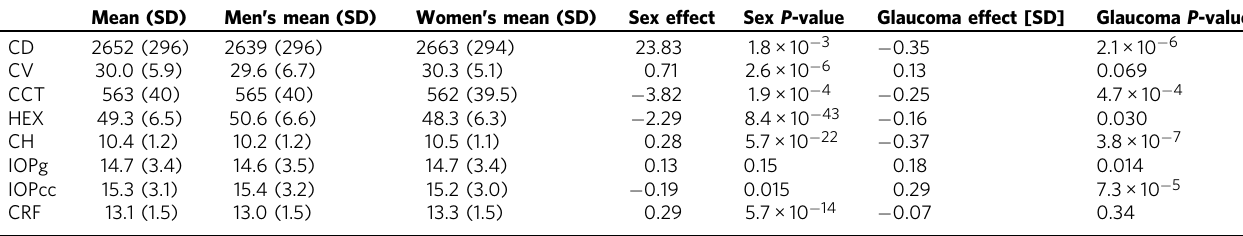
Table 1 Summary of